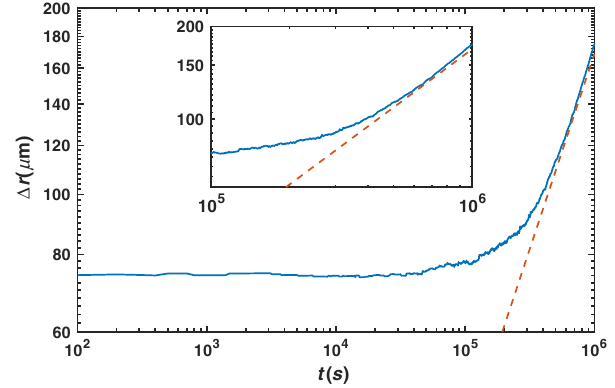
FIG. 6. The invasion distance Δ r ð t Þ [Eq. (10)] as a function of time. The exponent of the invasion distance, as indicated by the dashed line, determined using Δ r ∝ t ξ , is ξ ≈ 0 . 63 . Note that this value and the one extracted from experiments [33] are in reasonable agreement. The inset shows Δ r ð t Þ for t > τ average cell cycle time τ ¼ 1 τ